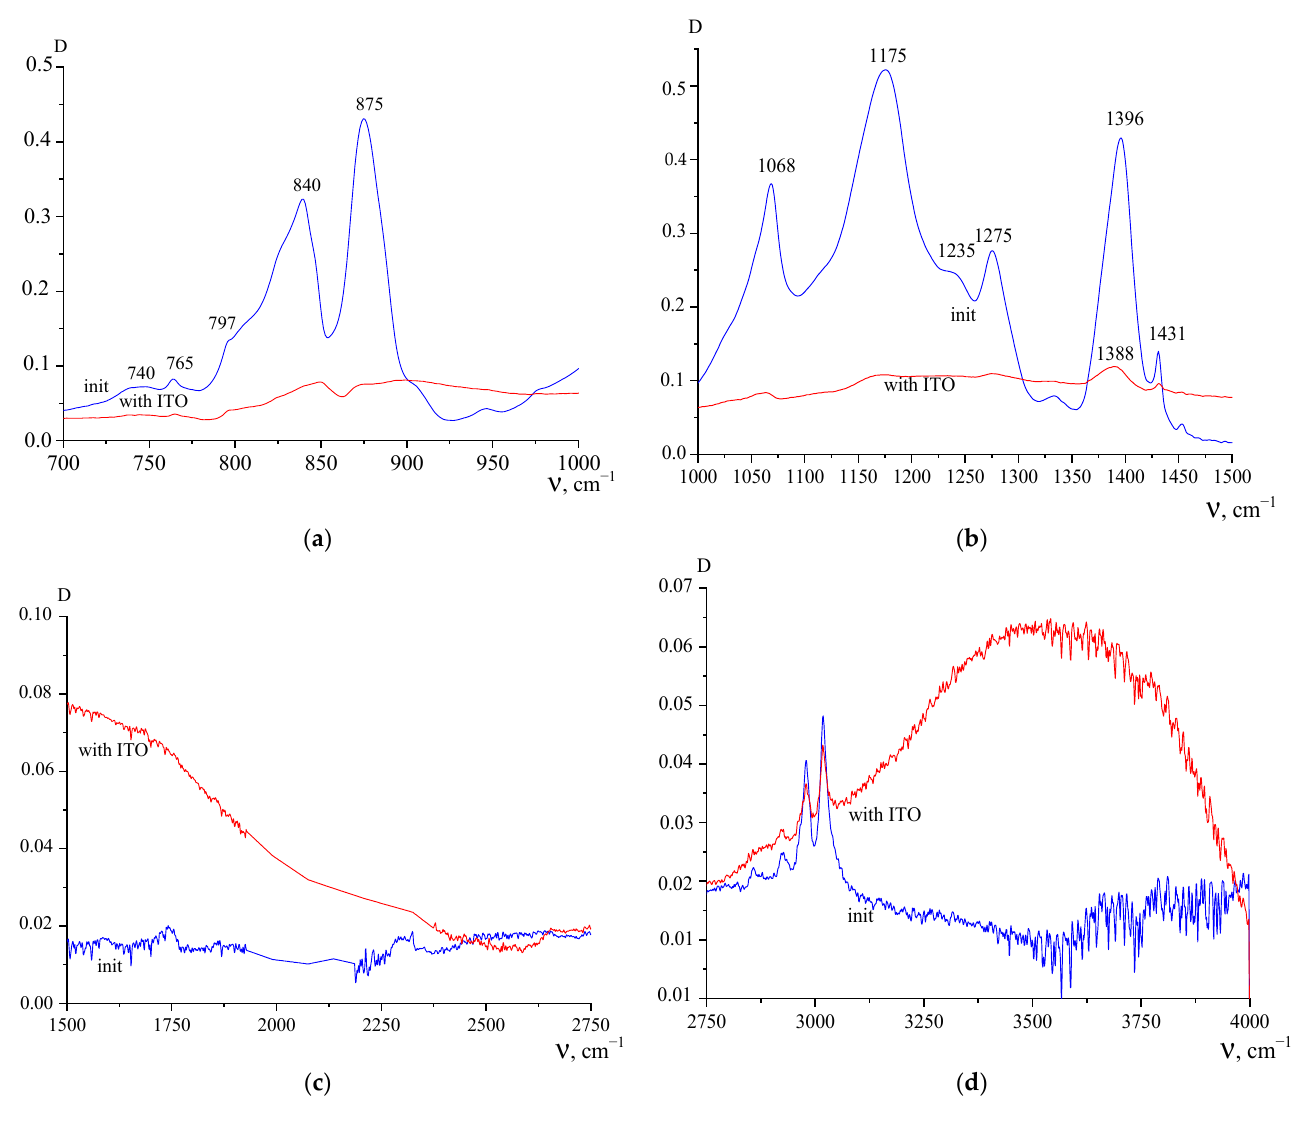
Figure 5. ATR IR absorption spectrum in the 700–1000 cm − 1 ( a ), 1000–1500 cm − 1 ( b ), 1500–2750 cm − 1 ( c ) and 2750–4000 с m − 1 ( d ) range for the original PVDF fi lm (init) and with applied ITO electrodes. Thermal treatment of fi lms with ITO electrodes (Figure 6) leads to an unusual e ff ect: